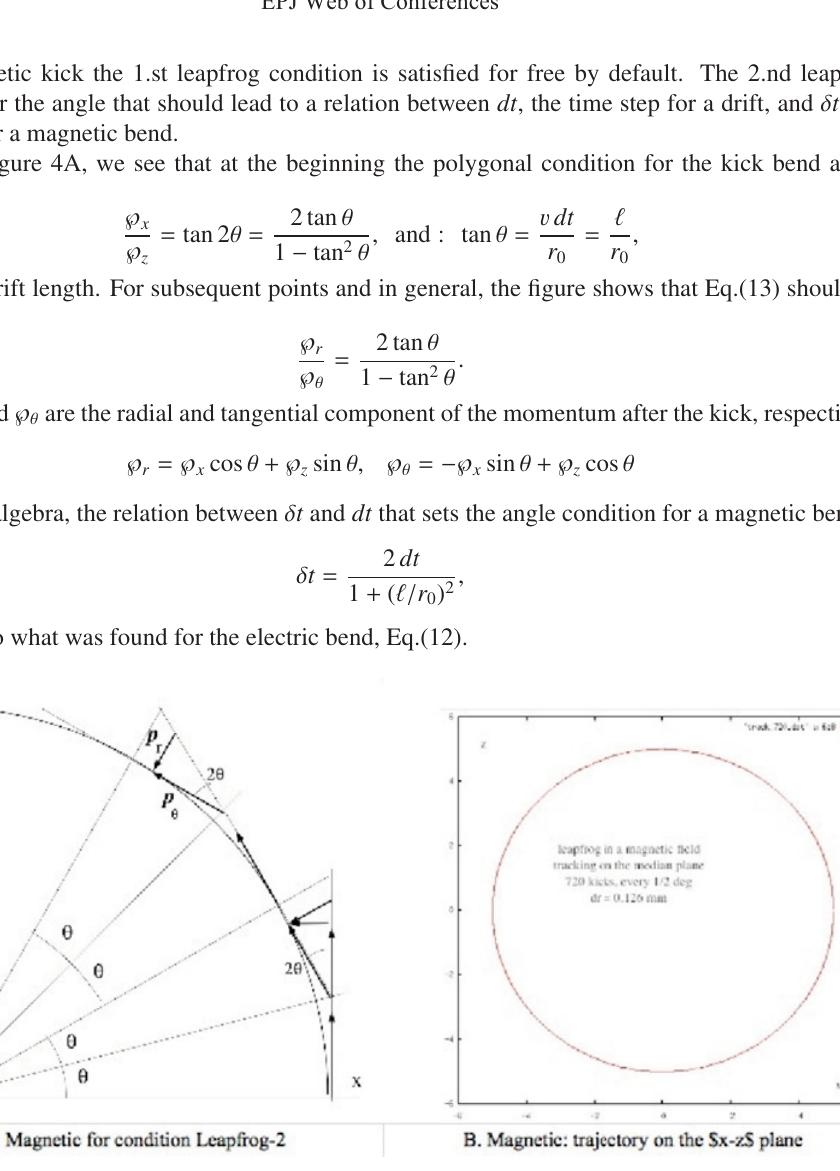
Figure 5. A.Magnetic-LF2, B.Magnetic